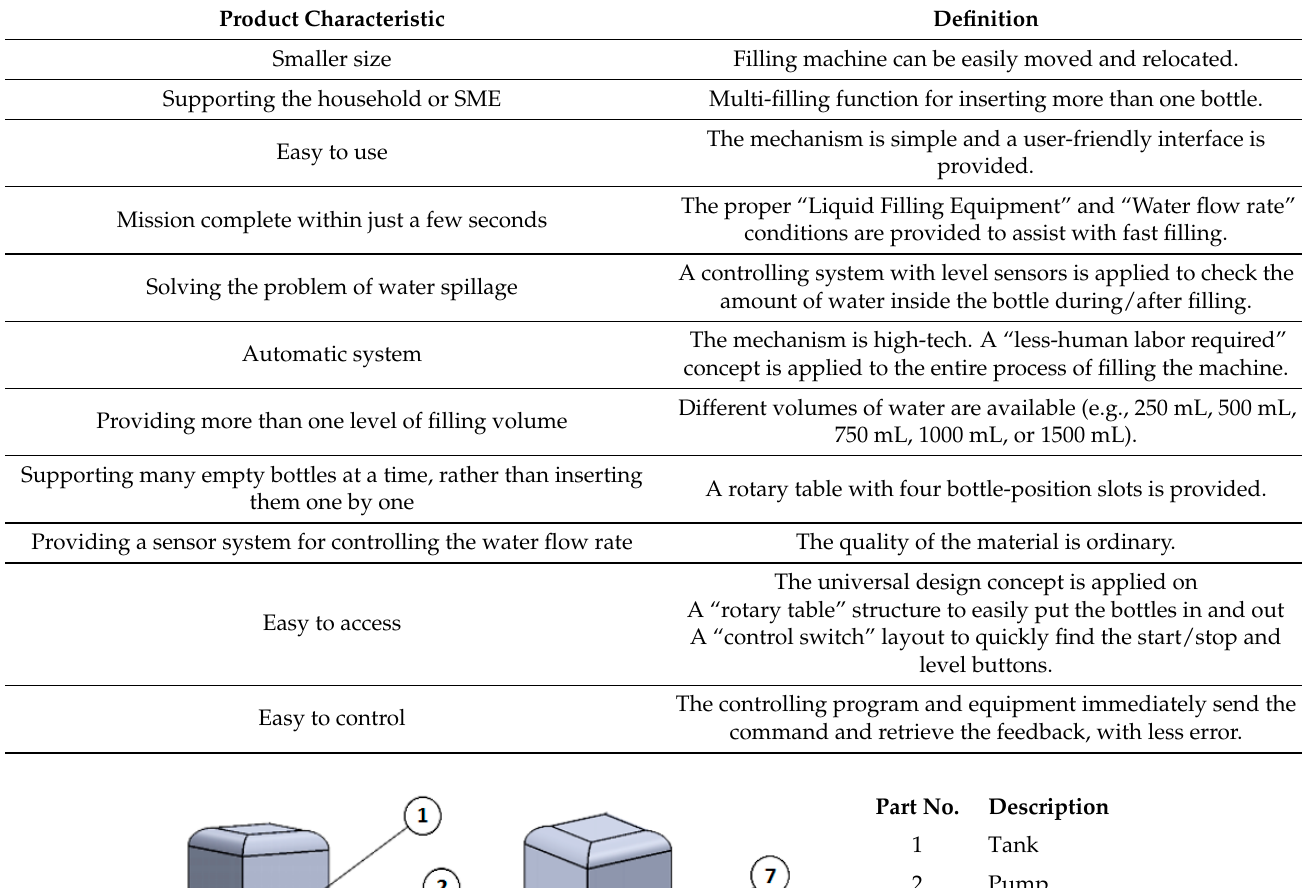
Table 8. Product characteristics and definitions.